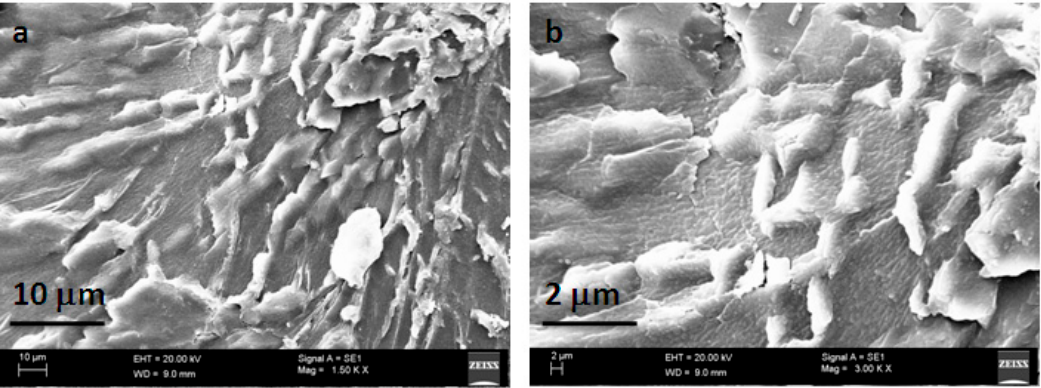
Figure 5. SEM images of PPK hydrogel for P2 formulation: ( a ) low magnification, and ( b ) high magnification ([ a ] × 1.50KX; [ b ] × 3.00KX).